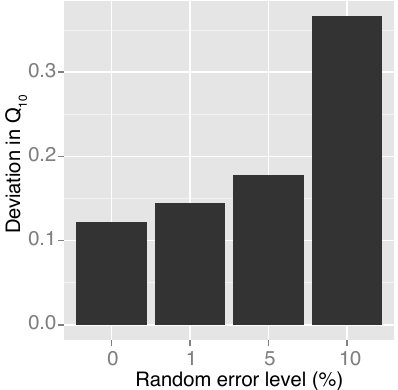
Figure 5. Sample of random error effects on inversion, constrained by one concentration measurement at 5cm. For this sensitivity test, the known Q 10 was